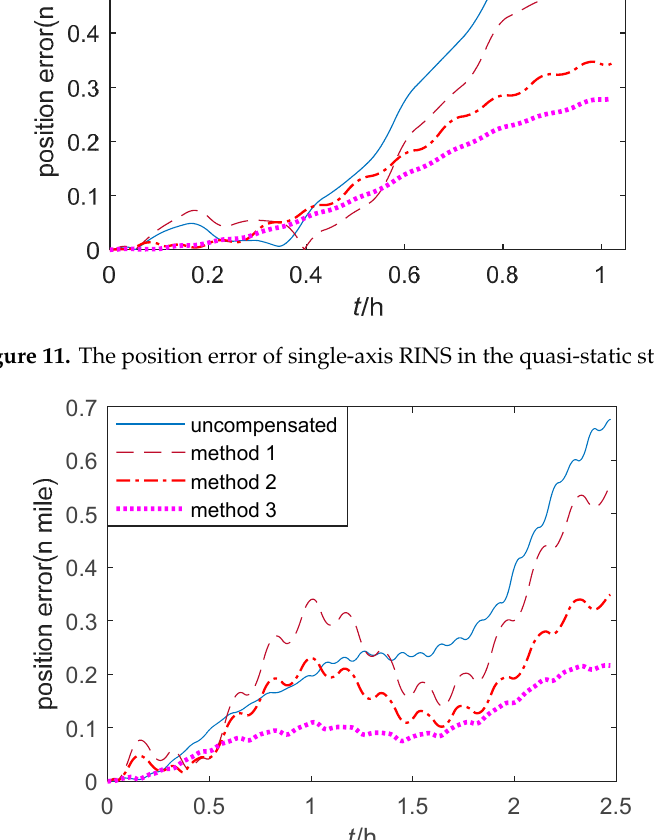
Figure 12. The position error of single-axis RINS in the swing state.